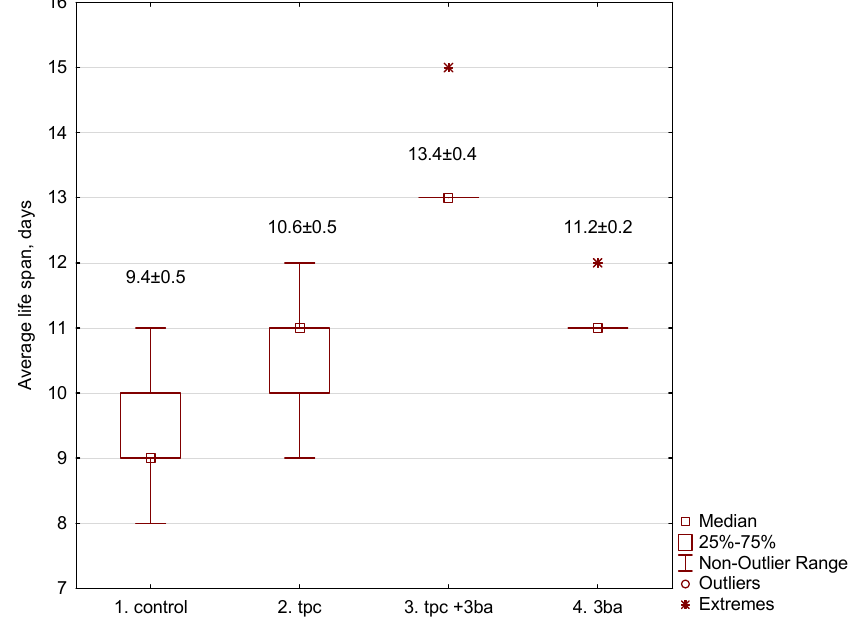
Figure 6. The influence of 3ba in combination with tpc on the lifespan of mice. The numbers above the boxes indicate the average lifespan in the group.